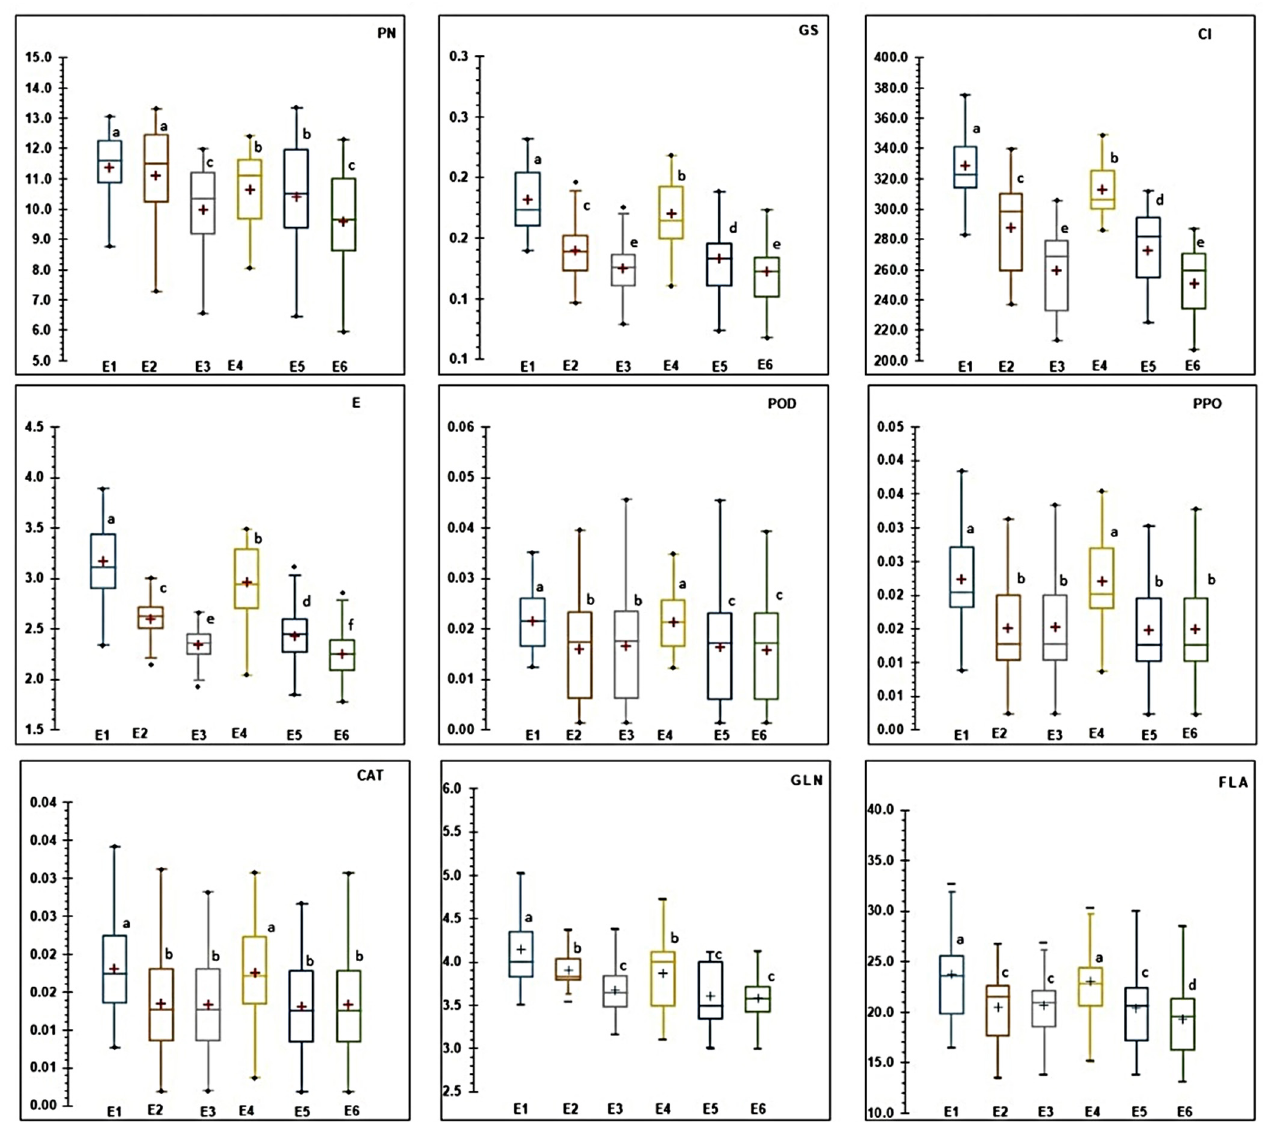
Figure 1. Boxplots illustrating the descriptive statistics of 12 measured traits in six environments of 20 genotypes wheat. The plus signs are treatment means, and the horizontal lines dividing the box represent the first quartile (25th percentile), medians and 3rd quartile (75th percentile). The lower and higher whiskers reflect the minimum and maximum values, respectively. The letters denote significant variation between the six environments at 0.01% levels of probability. Units of traits are as follows: canopy temperature (CT), Leaf water content (LWC), relative water content (RWC), net photosynthesis (Pn) rate, stomatal conductance (Gs), intracellular CO2 concentration (Ci), transpiration rate (E), peroxidase (POD), polyphenol oxidase (PPO), catalase (CAT), green leaf number (GLN), flag leaf area (FLA).